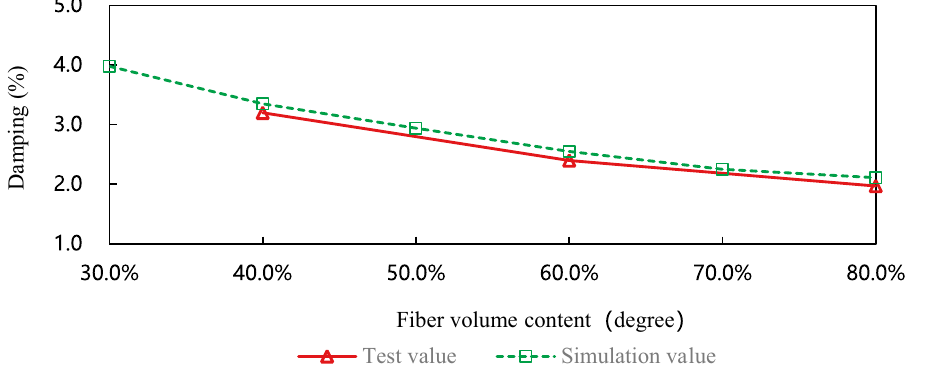
Figure 11. The damping contrast curves of leaf springs with different volume